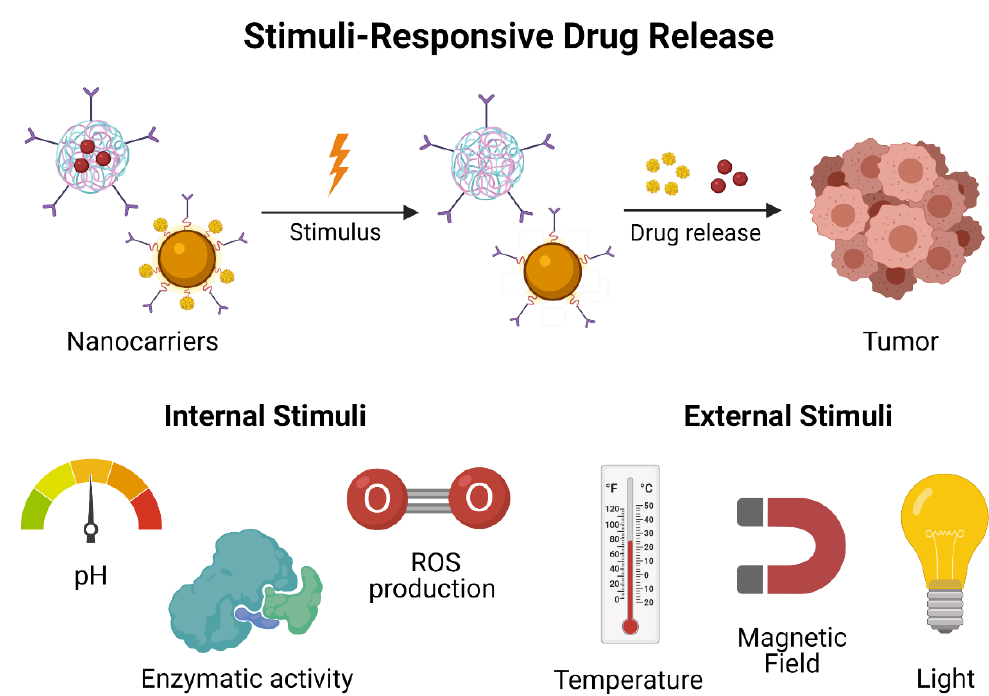
Figure 3. Schematic illustration of stimuli-responsive drug release. Drug release can be started by internal (pH, ROS production, and enzymatic activity) and external (temperature, magnetic field, and light) stimuli.